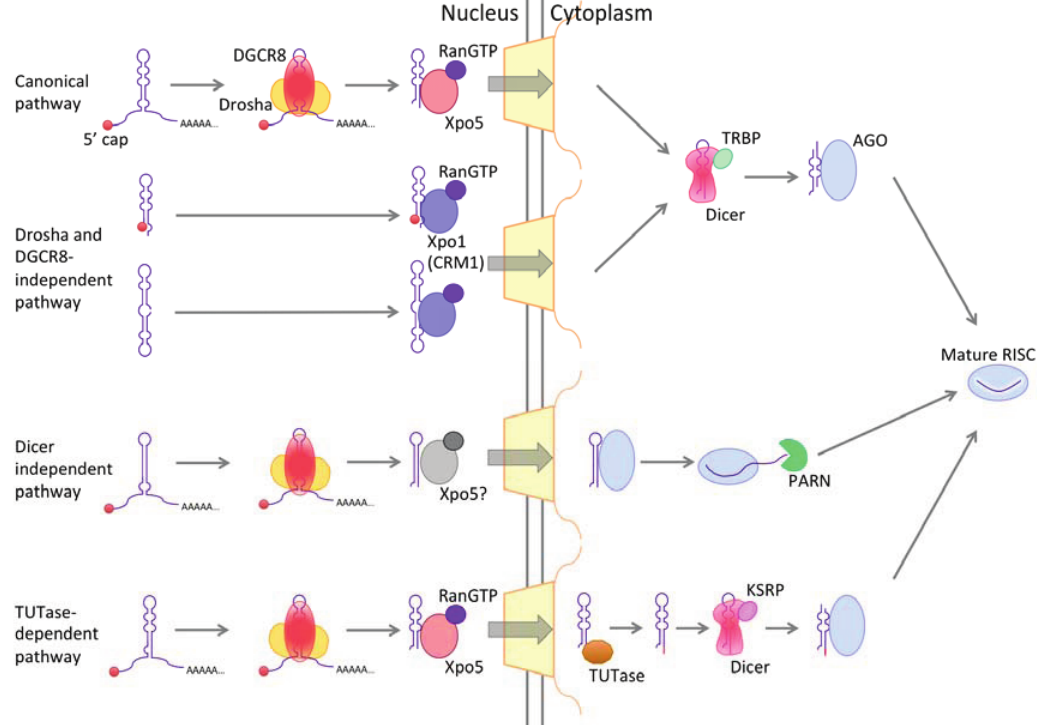
Figure 5. MicroRNA export pathways. Nascent miRNA is processed in both the nucleus and the cytoplasm. The nuclear export receptor involved in the Dicer-independent pathway is